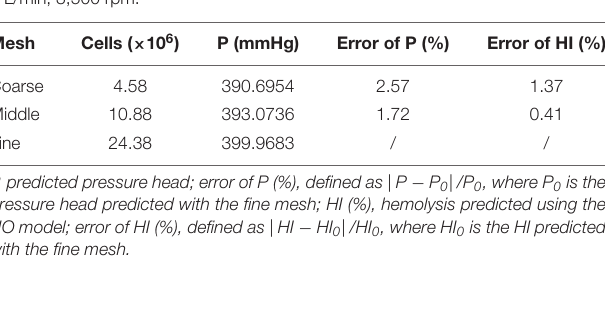
Frontiers in Physiology |